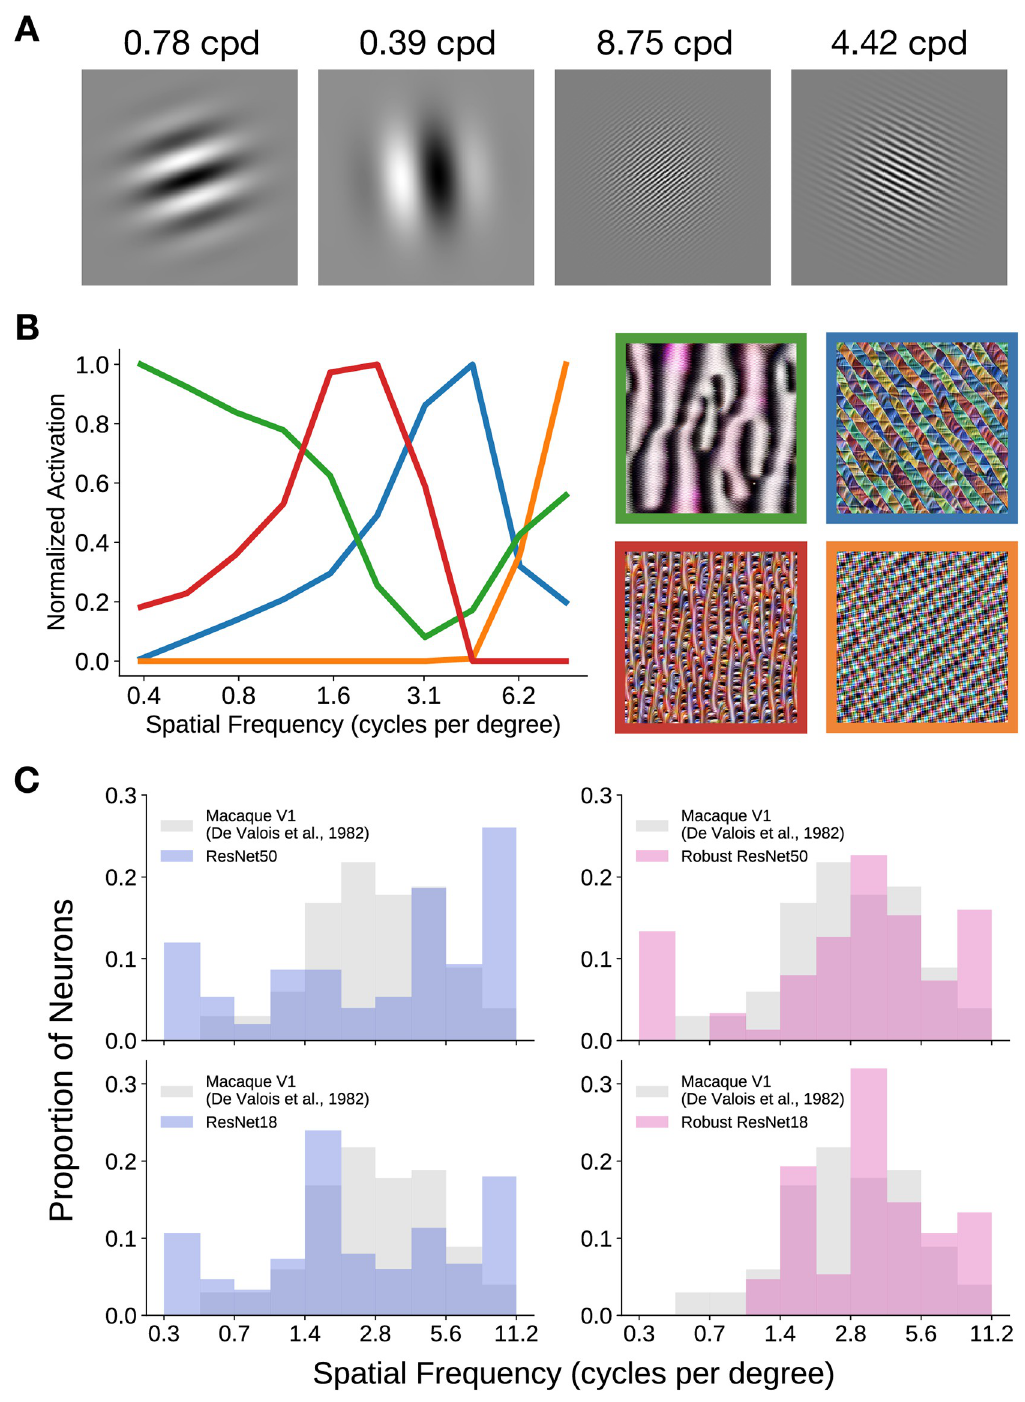
Fig 4. Assessing the spatial frequency tuning of models. We performed in-silico electrophysiology experiments to extract spatial frequency tuning curves of representative artificial neurons from the most “V1-like” layer of a model, as determined by neural predictivity. The field of view of these models was assumed to be 6.4˚ per image. A . A few example Gabor patch stimuli of different orientations, phases and frequencies, that were used in the in-silico electrophysiology experiments. cpd: cycles per degree. B . A few example spatial frequency tuning curves are plotted, each corresponding to an artificial neuron (i.e., convolutional filter). The images are the stimuli that optimally excite the corresponding channel in the output of the most “V1-like” ResNet-50 model layer. C . Preferred spatial frequency distributions for robust and non-robust models from one in- silico experiment. We can see that the distributions of the robust models are more similar to that of macaque V1 cells than the distributions of non-robust models. Top: Robust and non-robust ResNet-50. Bottom: Robust and non-robust ResNet-18.